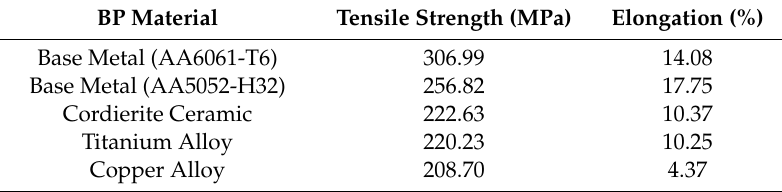
Figure 8. Stress–strain curves of the joints obtained using different BP materials. Table 3. Mechanical properties of the joints obtained using different BP materials.